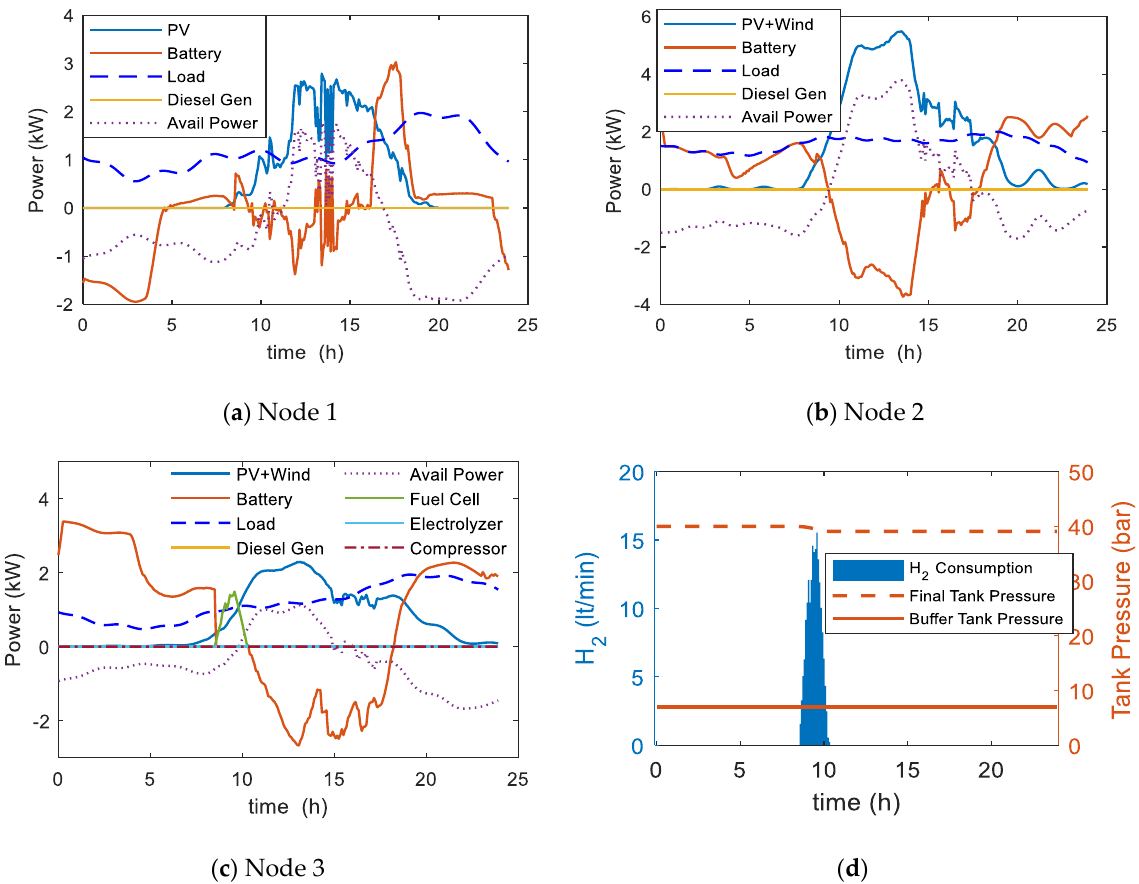
Figure 16. ( a – c ) Systems operation with the NMPC enabled and with unpredicted conditions; ( d ) Hydrogen consumption and storage tanks pressures.